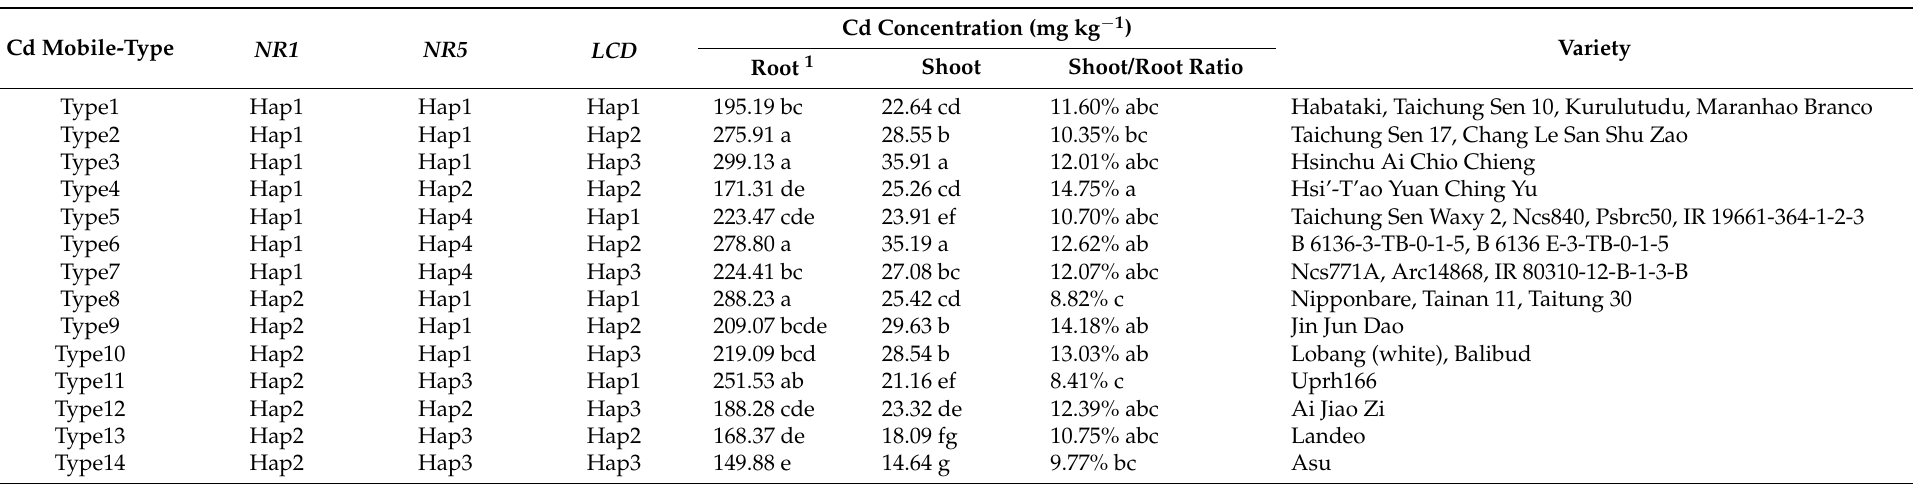
Table 1. The Cd concentrations for representative varieties of 14 Cd-mobile types tested in hydroponic experiments.